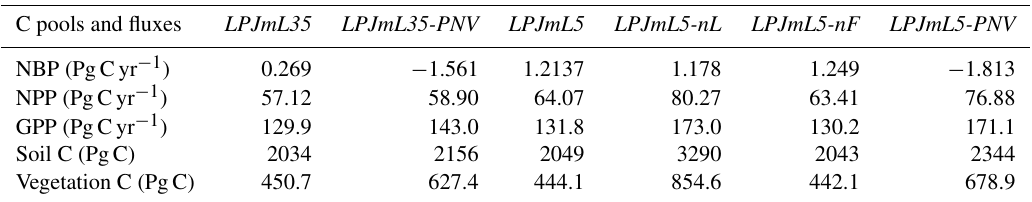
Table 3. Global carbon pools (soil and vegetation carbon) and fluxes (net biome productivity NBP, net primary productivity NPP, and gross primary productivity GPP) for the six different experiments (averages over the period 2000 to 2009). The suffix -PNV denotes experiments with potential natural vegetation, -nL with unlimited N supply, and -nF without fertilizer input.